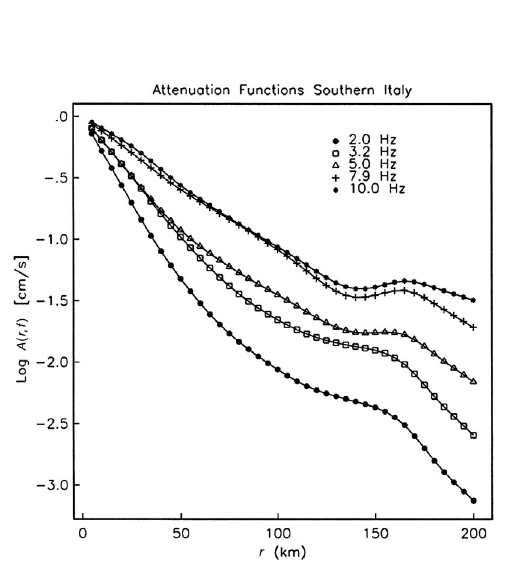
Fig. 7. A sample of NAF obtained for frequencies between 2 and 10 Hz.